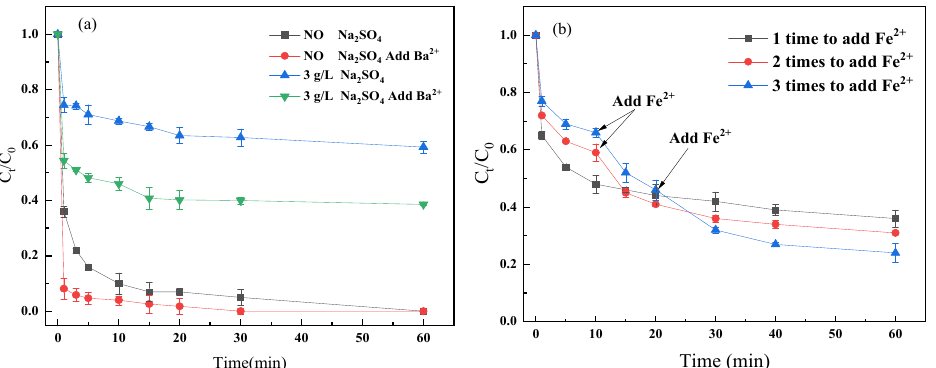
Figure 5. Methods to offset the adverse effects of SO 4 2 − on degradation of pollutants in ferrous/PS system: ( a ) Ba 2+ addition; ( b ) batch addition of Fe 2+ . [PDS] 0 = 40 mg/L, Fe 2+ /PS = 0.3.